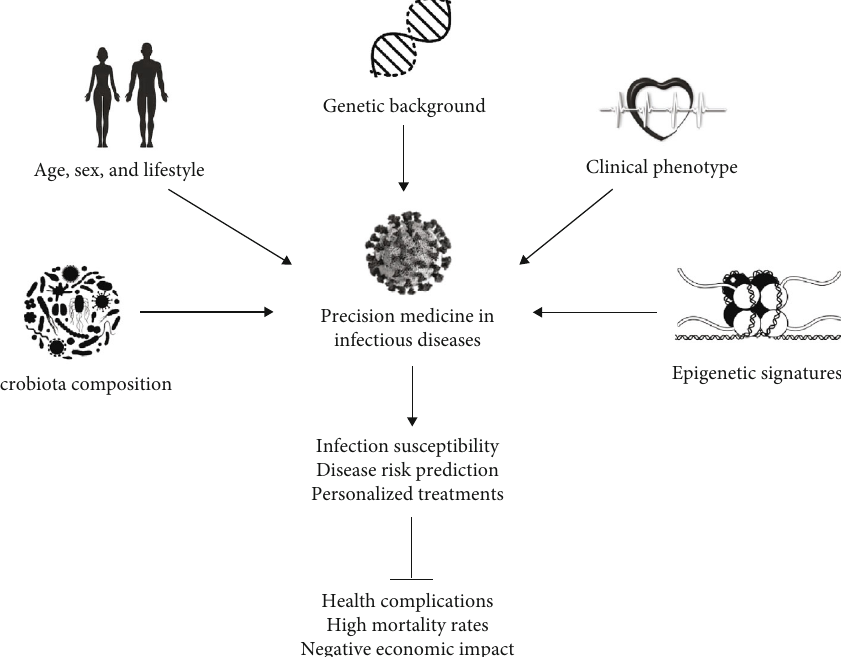
Figure 2: Genetic background and other precision parameters as important predictors of SARS-CoV infection and personalized translational medicine